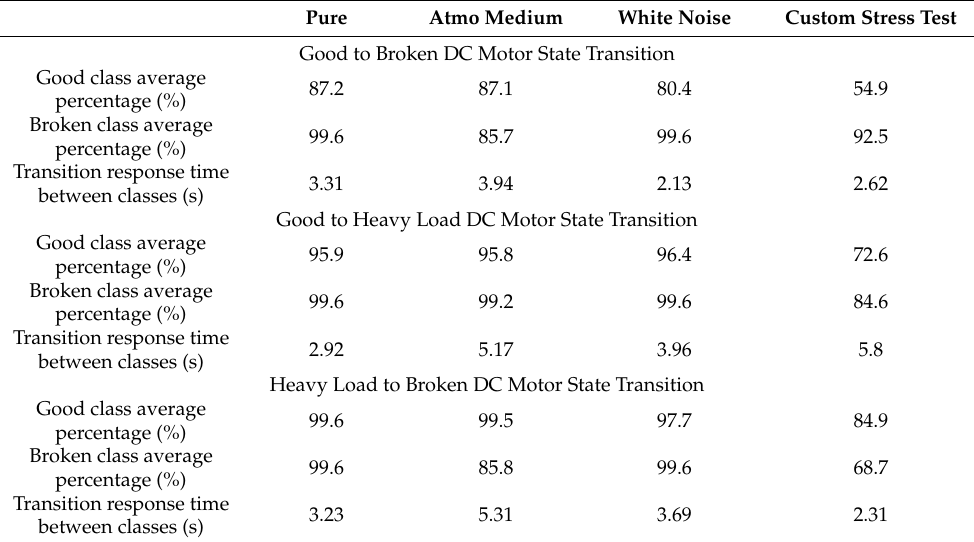
Table 8. Average percentage indications for each class and environmental background along with transition response times between classes for the Edge Impulse methodology